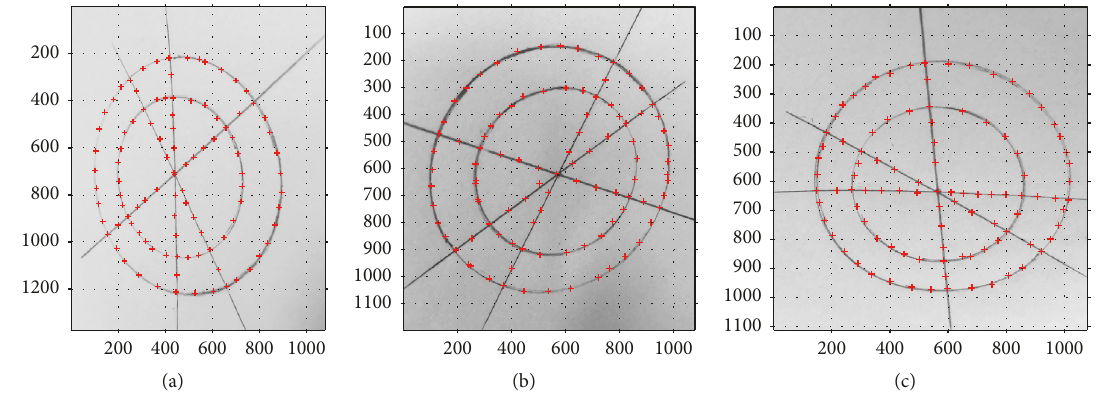
Figure 5: Extracting the